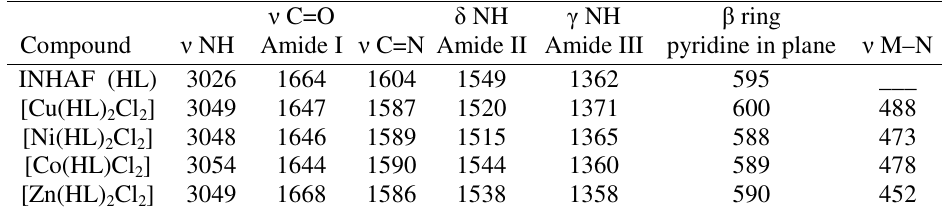
Table 2. Characteristic IR bands (cm -1 ) of the ligand INHAF and its complexes.